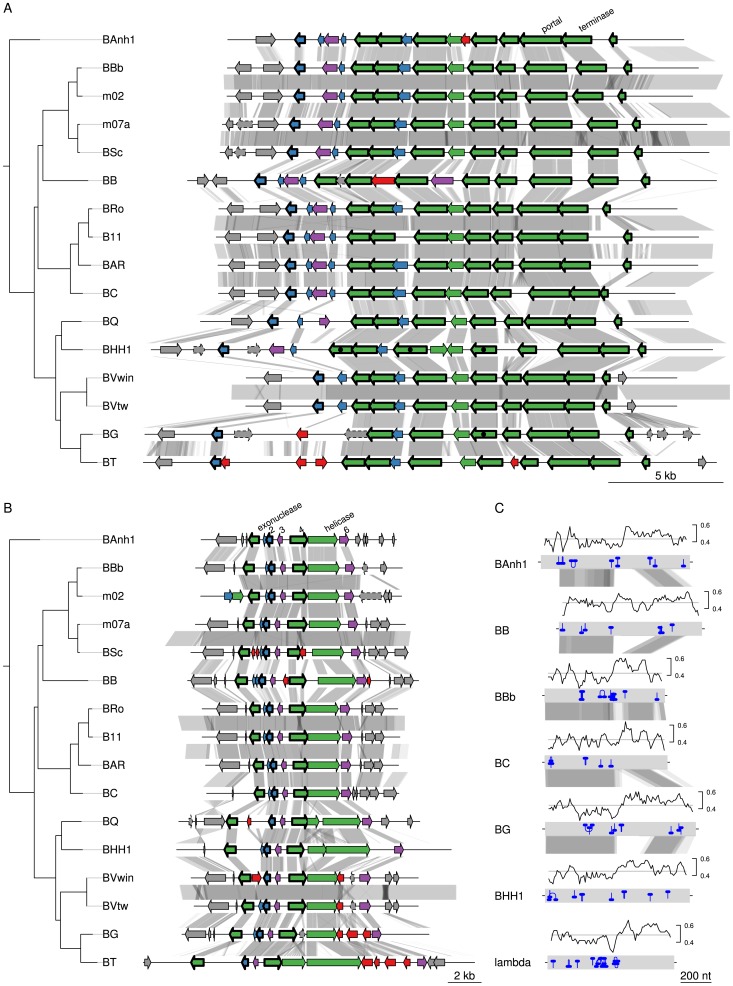
Gene order structures of the BaGTA and ROR segments.Comparative analysis of the DNA segments covering the BaGTA genes (A) and the ROR genes (B). Genes are colored according to their phylogenetic classification (see methods), without manual intervention: vertically inherited (magenta), imported (green), Bartonella-specific (blue) and ORFans (red). Genes acquired in the common ancestor of Bartonella and conserved in length and present in all genomes are marked with a thick border around the arrow depicting the gene. Those that are not bordered were presumably acquired in the common ancestor but have since then been lost or slightly modified in one or a few species. Pseudogenes are marked with a dotted border. Proteins experimentally detected by mass-spectrometry as part of the BaGTA phage particles [9] are marked with a filled black circle inside the arrow depicting the gene in B. henselae or B. grahamii. Genes shown in grey represent core genes not part of the BaGTA or the ROR. Horizontal grey lines indicate tblastx hits, with grey intensity reflecting the tblastx e-values. The repeat structure and GC content of gene number 4 in the ROR region is shown in (C). Blue lines indicate palindromic repeats. The graphs above the gene (grey bands) show the GC content in a 50-bp window. The average is indicated with a horizontal line. Abbreviations of Bartonella species names are as in Table 1.